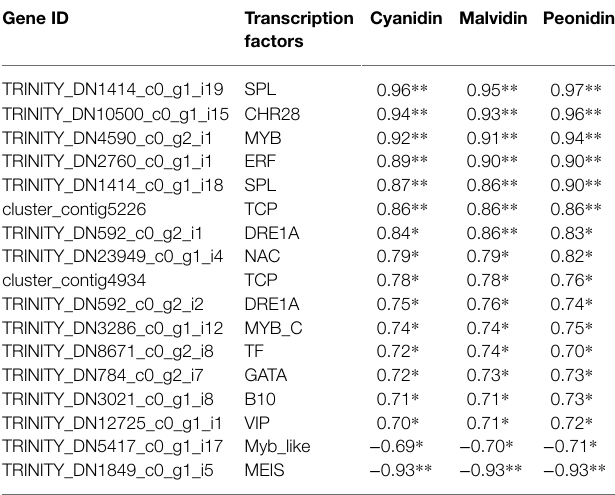
TABLE 3 | Transcription factors significantly correlated with cyanidin, malvidin, and